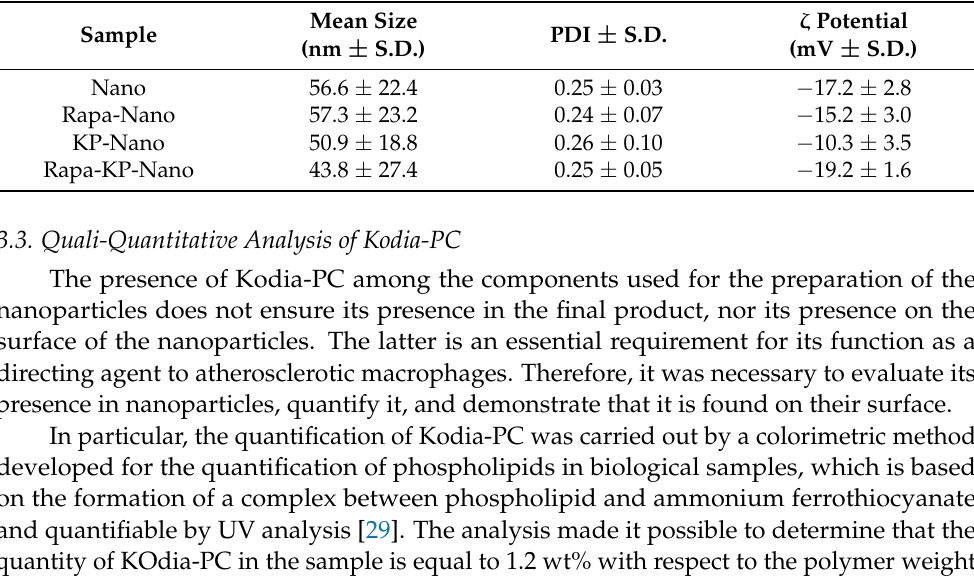
Table 1. Mean size, polydispersity index (PDI) and ζ potential values of empty and rapamycin (Rapa)-loaded untargeted particles (Nano) and nanoparticle surface (KP-Nano) in bidistilled water. Data represents the media of three